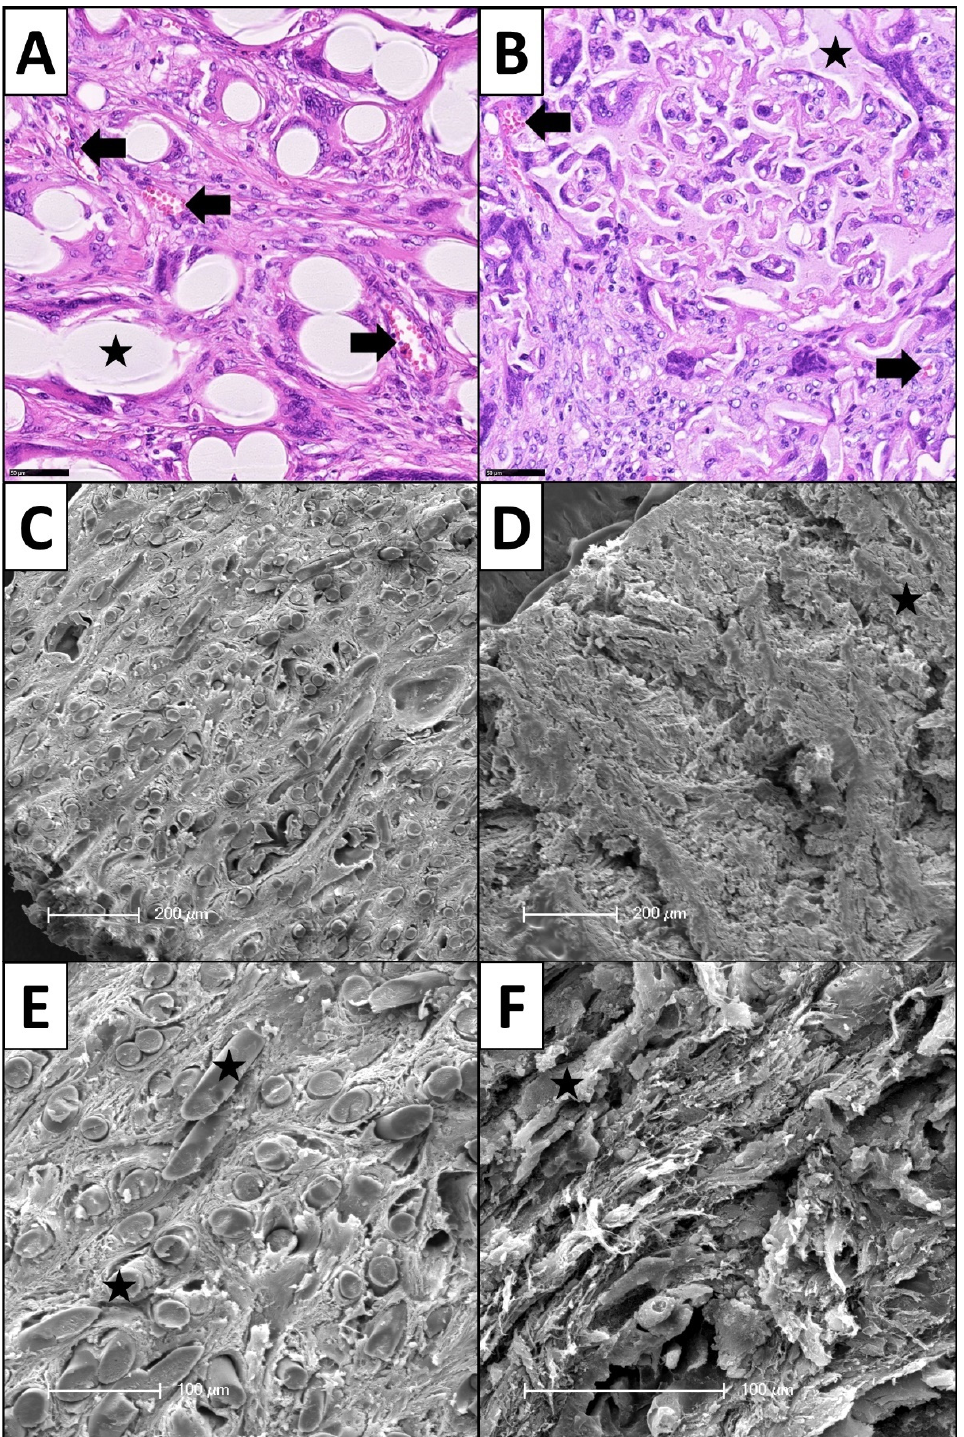
Figure 6. Histopathological and SEM images as examples of tissue ingrowth into the macroporous biomaterial scaffolds during subcutaneous implantation period. ( A ) Neovascularization (arrows) between the fibers of a filamentous fleece (star), H&E staining, magnification × 200. ( B ) Neovas- cularization in between the spongy elements (star). ( C , E ) SEM images of tissue ingrowth in be- tween a filamentous biomaterial (star). ( D , F ) SEM images of tissue ingrowth in between a spongy biomaterial